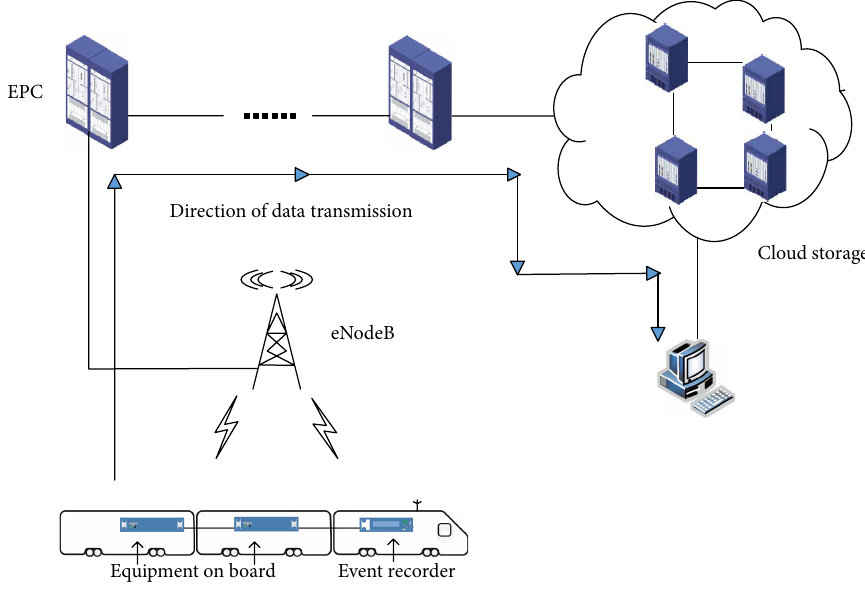
Figure 13: Data transmission process from the train to the